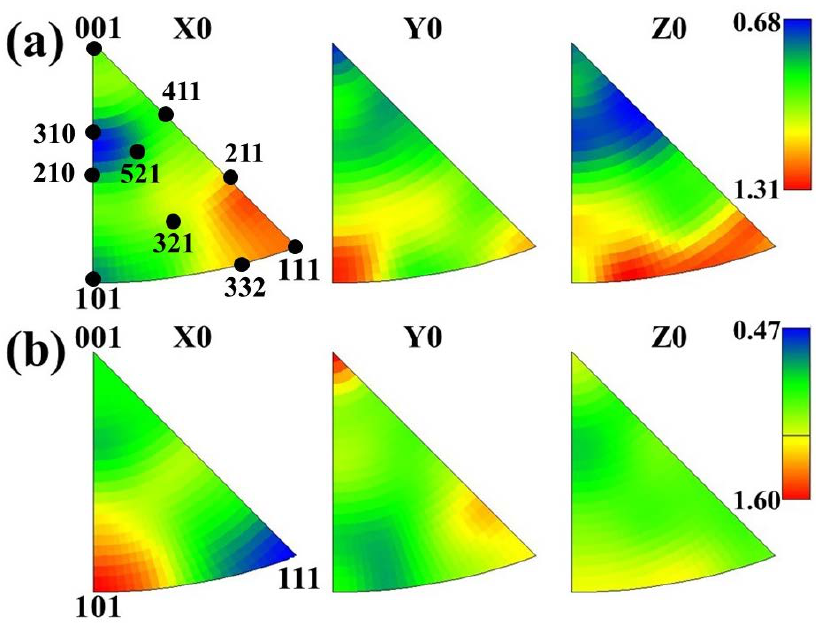
Figure 11. IPF of main texture component with different C content: ( a ) ELC, ( b ) LC. ND fiber texture distribution and fraction of orientation deviation from {111} <uvw>